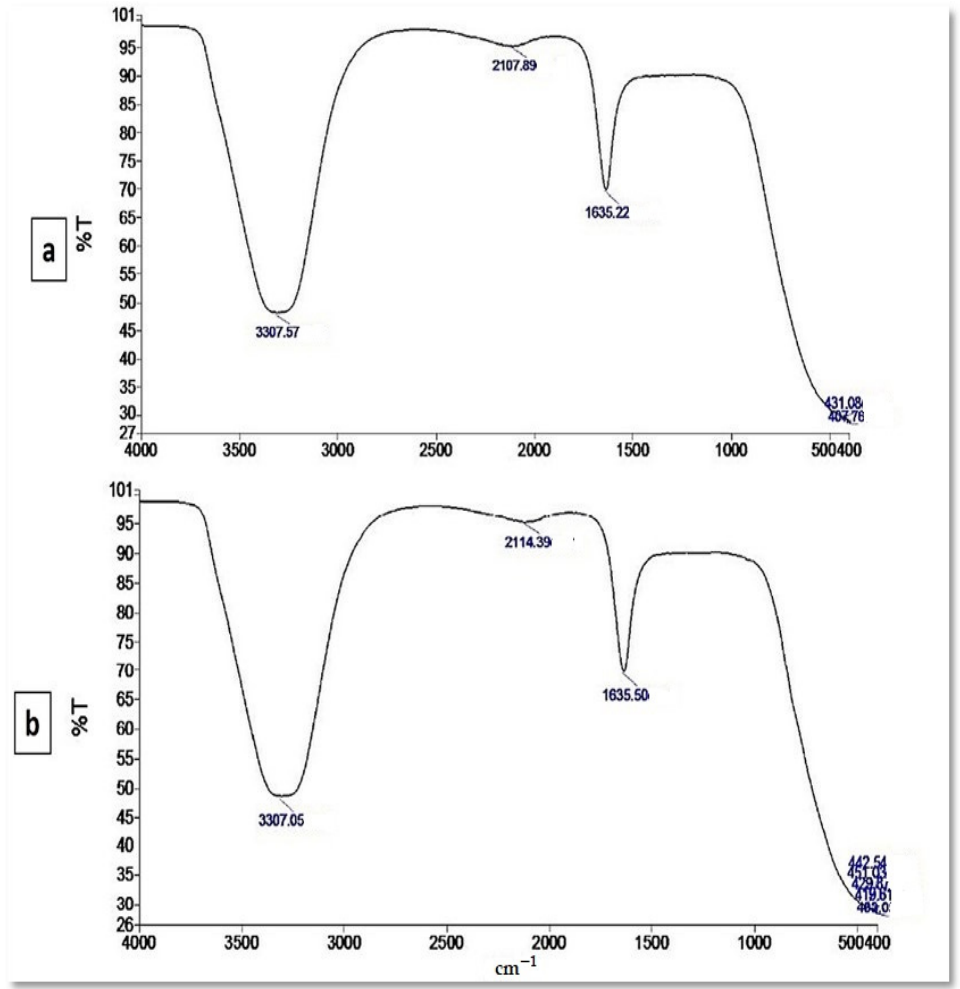
Figure 5. FTIR pattern ( a ) culture supernatant, and ( b ) myco-synthesized selenium nanoparticles, where Y-axis represented the transmission (%T) and X-axis represented the wavenumber (cm − 1 ). 3.4. Effects of Selenium Nanoparticles against B. alexandrina Snails The present findings revealed that SeNPs have a molluscicidal effect against adult B.